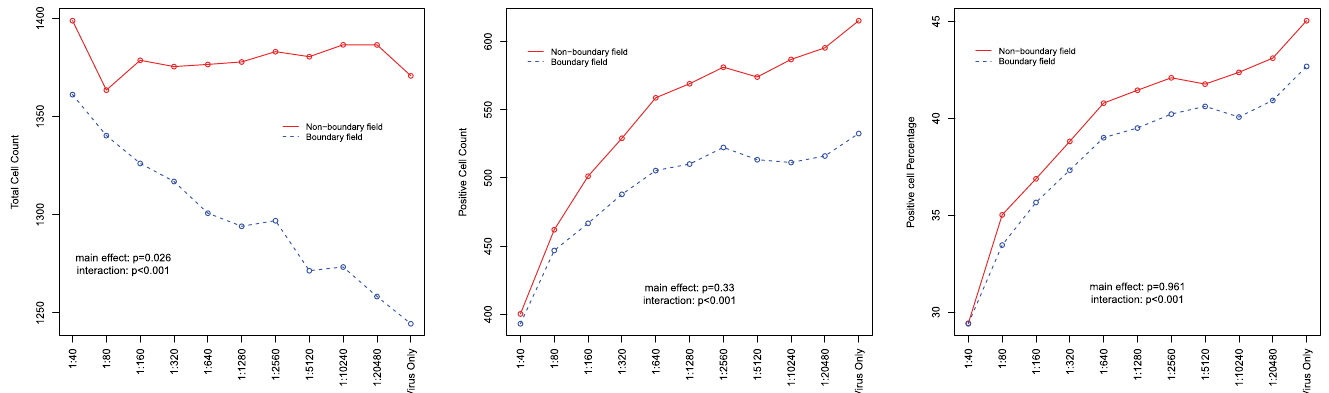
Fig 6. Comparison of cell count by field location. Comparison of total cell count, positive cell count and positive cell percentage between boundary fields and non- boundary fields by plate column. Cell counts and percentages are averaged across samples, replicates and fields. Statistical significance was assessed via GEE linear regression models that controlled for the effects of plate and replicate and adjusted for repeated measures among samples.